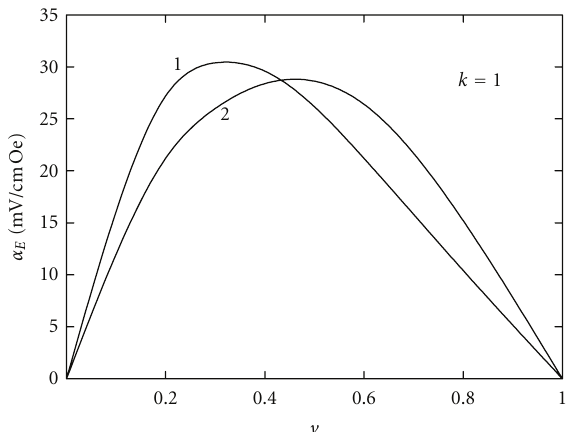
Figure 5: (1) Longitudinal and (2) transverse ME voltage coe ffi - cients as functions of PZT volume fraction for symmetric layered structure of La 0 . 3 Sr 0 . 7 MnO 3 (LSMO) and PZT for interface coupling parameter k = 1.